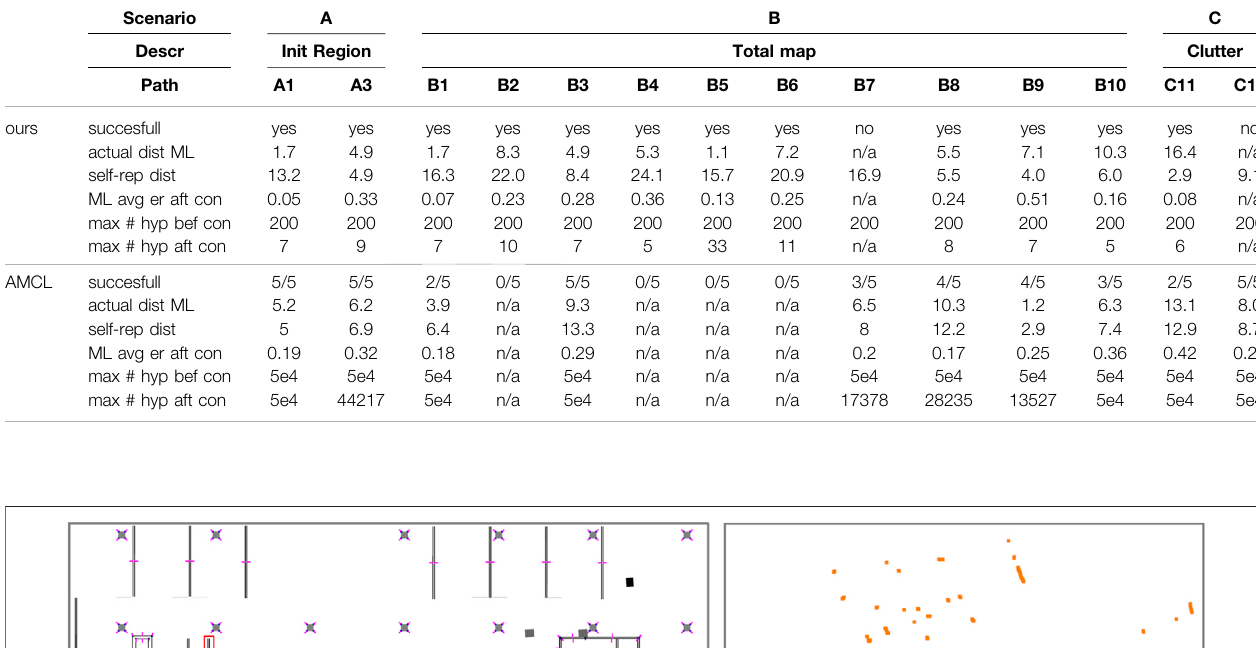
TABLE 3 | Results of the localization using our method and AMCL. The predicate succesfull is yes when the robot localizes accurately with respect its ML hypothesis error stays localized for the remainder of the path. The distance needed to acquire localization is both expressed as actual localization of ML and as self-reported localization (by assessing convergence). Note that self-reported localization can be reported erroneously (i.e.,. false con fi dence). The average ML error after localization is also reported and the average number of hypotheses used both before and after self-reported localization has been achieved.